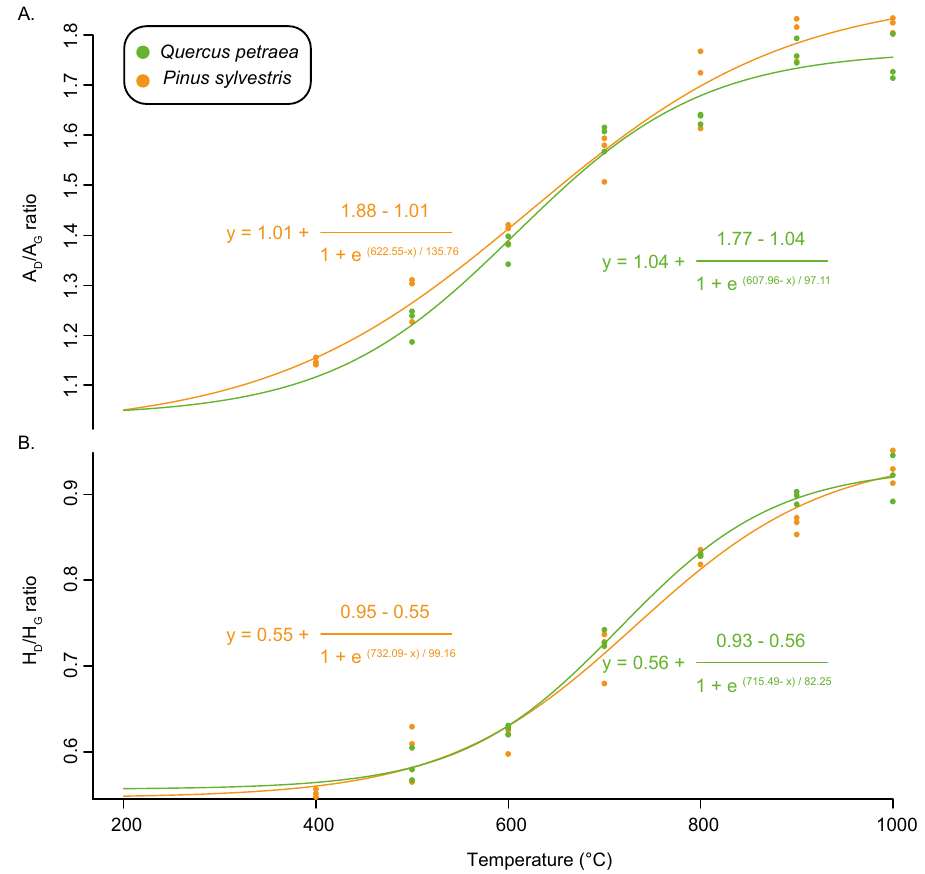
Figure 3. Relationships between ( A ) the A D /A G and ( B ) H D /H G ratios and carbonisation temperatures in oak and pine charred